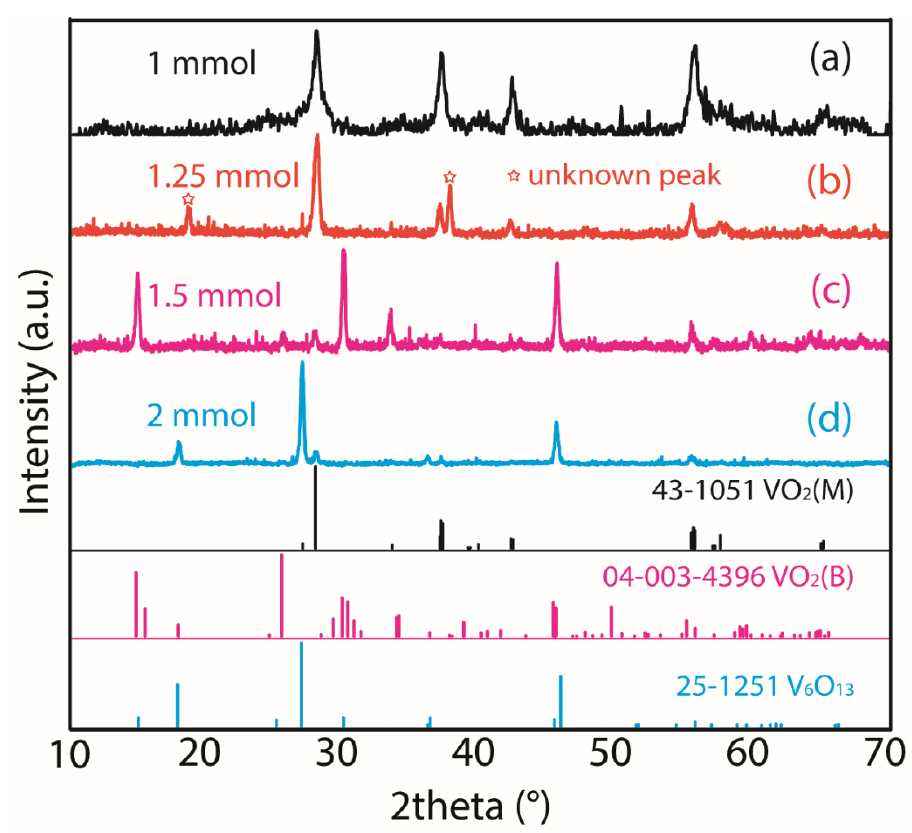
Figure 5. ( a – d ) XRD patterns of hydrothermal samples with different precursor concentrations at 260 °C with 60 μL N 2 H 4 ·H 2 O and 24 h duration. Stars in Figure 5b indicate the unknown peaks.